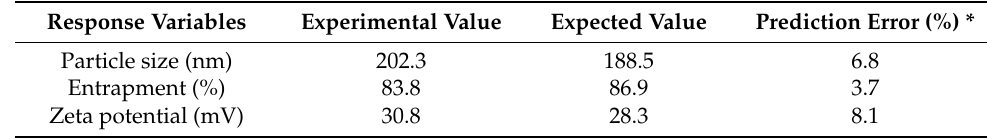
Table 4. Experimental, model expected and prediction error values of the optimized BER-CTS-BLS